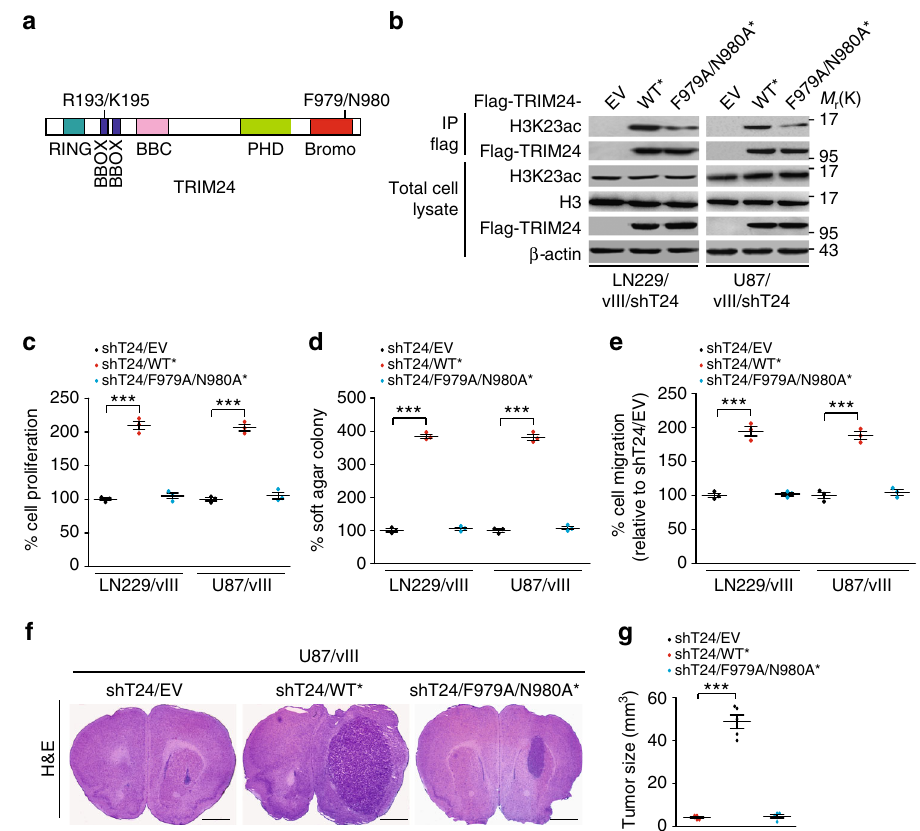
Fig. 4 Binding of TRIM24 with H3K23ac is required for EGFR-driven tumor growth. a Schematic of TRIM24. RING, RING domain; BBOX, B box domain; PHD, plant homeodomain; Bromo, Bromodomain. b Re-expression of Flag-TRIM24 shRNA-resistant TRIM24 WT* , but not TRIM24 F979A/N980A* mutant (F979A/N980A*) or an empty vector control (EV), restores the association between H3K23ac and TRIM24 in LN229/vIII/shT24 and U87/vIII/shT24 GBM cells. c – e Re-expression of Flag-TRIM24 shRNA-resistant TRIM24 WT* , but not TRIM24 F979A/N980A* mutant rescues EGFRvIII- stimulated cell proliferation ( c ), colony formation in soft agar ( d ) and cell migration ( e ) in TRIM24 knockdown EGFRvIII glioma cells. f Re-expression of Flag-TRIM24 shRNA-resistant TRIM24 WT* , but not TRIM24 F979A/N980A* mutant rescues EGFRvIII-stimulated tumor growth in TRIM24 knockdown EGFRvIII glioma brain xenografts. Images represent results of 5 mice per group of 2 independent experiments. Scale bars: 1 mm. g Quanti fi cation of tumor size. Data were from stained brain sections of fi ve mice per group of two independent experiments. Error bars, s.d. Data represent two or three independent experiments with similar results. *** P < 0.001, paired two-way Student ’ s t -test, compared with EGFRvIII cells or tumors treated with association with H3K23ac in both U87 and LN229 GBM cells